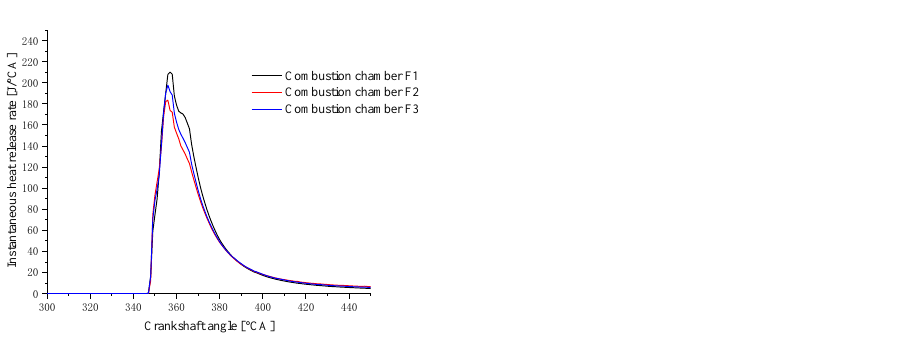
Figure 16. Comparison of cylinder pressure curves of three combustion chamber schemes matched with the 160° spray angle injector.